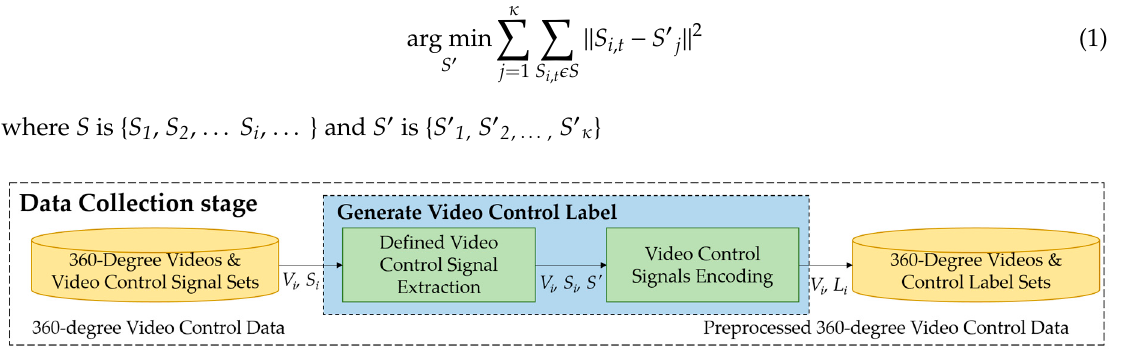
Figure 3. Preprocessing to input 360-degree video control data into the deep learning model.